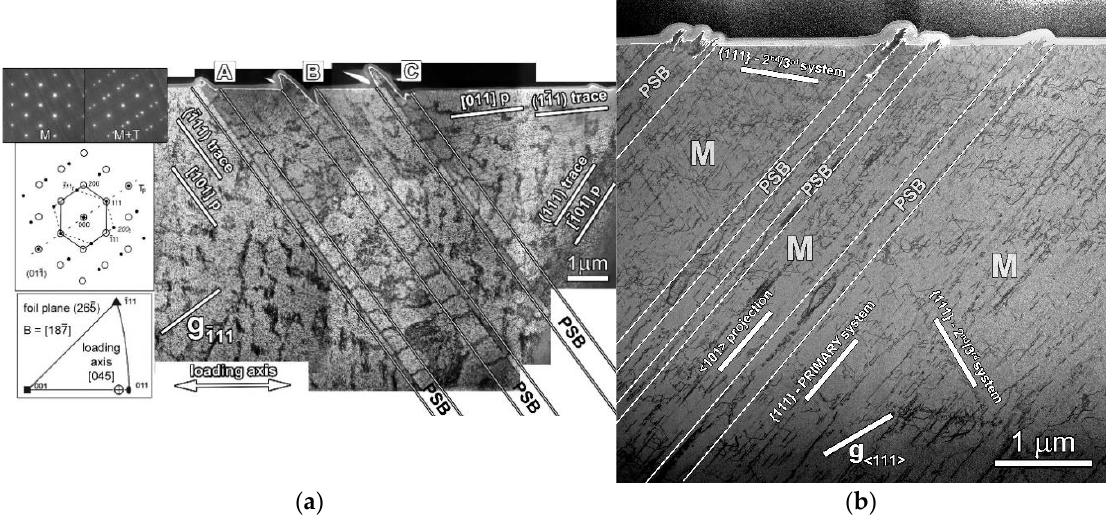
Figure 6. TEM images of the surface foils prepared from the grains of fatigued metals showing both the surface relief and internal dislocation structure; ( a ) polycrystalline copper fatigued at 78 K, ( b ) superaustenitic Sanicro 25 steel fatigued at room temperature.